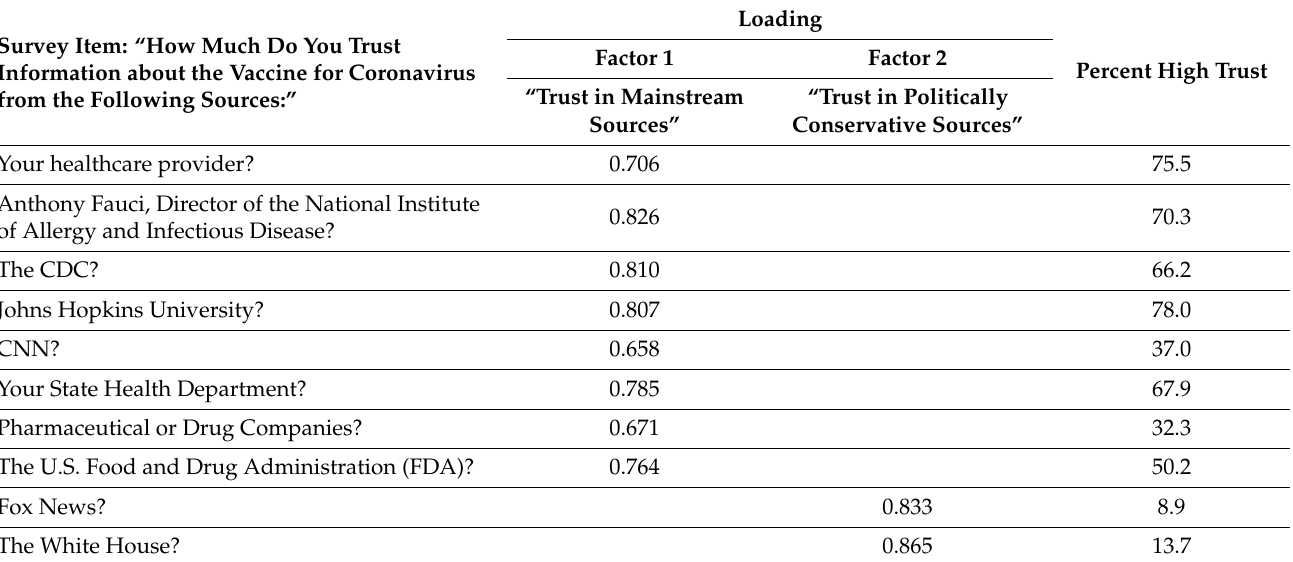
Table 3. Factor analysis and percentage of high trust ratings for each informational source among study respondents in the US, 2020 ( N =